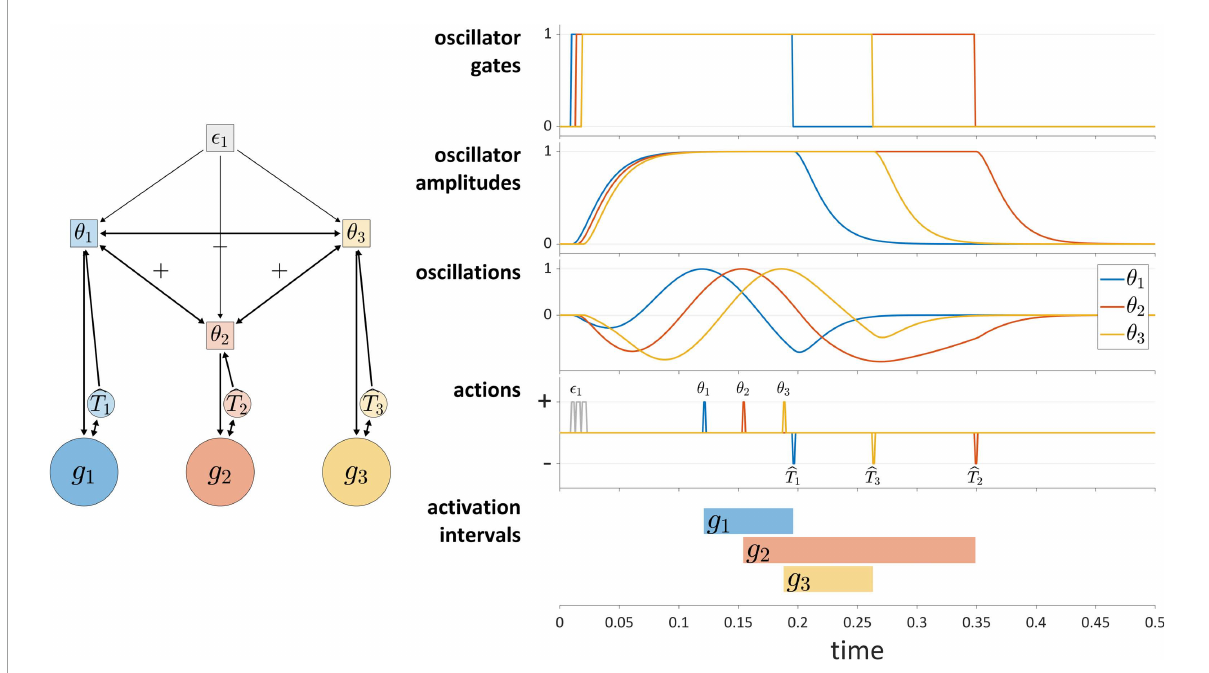
FIGURE7 The coupled oscillators model in the TiR framework. Periodic TiRs θ 1, θ 2, and θ 3 are phase coupled as indicated by +/– symbols. The oscillator gates, radial amplitudes, and oscillations (amplitude × cosine of phase) are shown. Due to the pattern of phase coupling imposed here, initiation of gestural systems g 1 and g 3 are symmetrically displaced from initiation of g 2